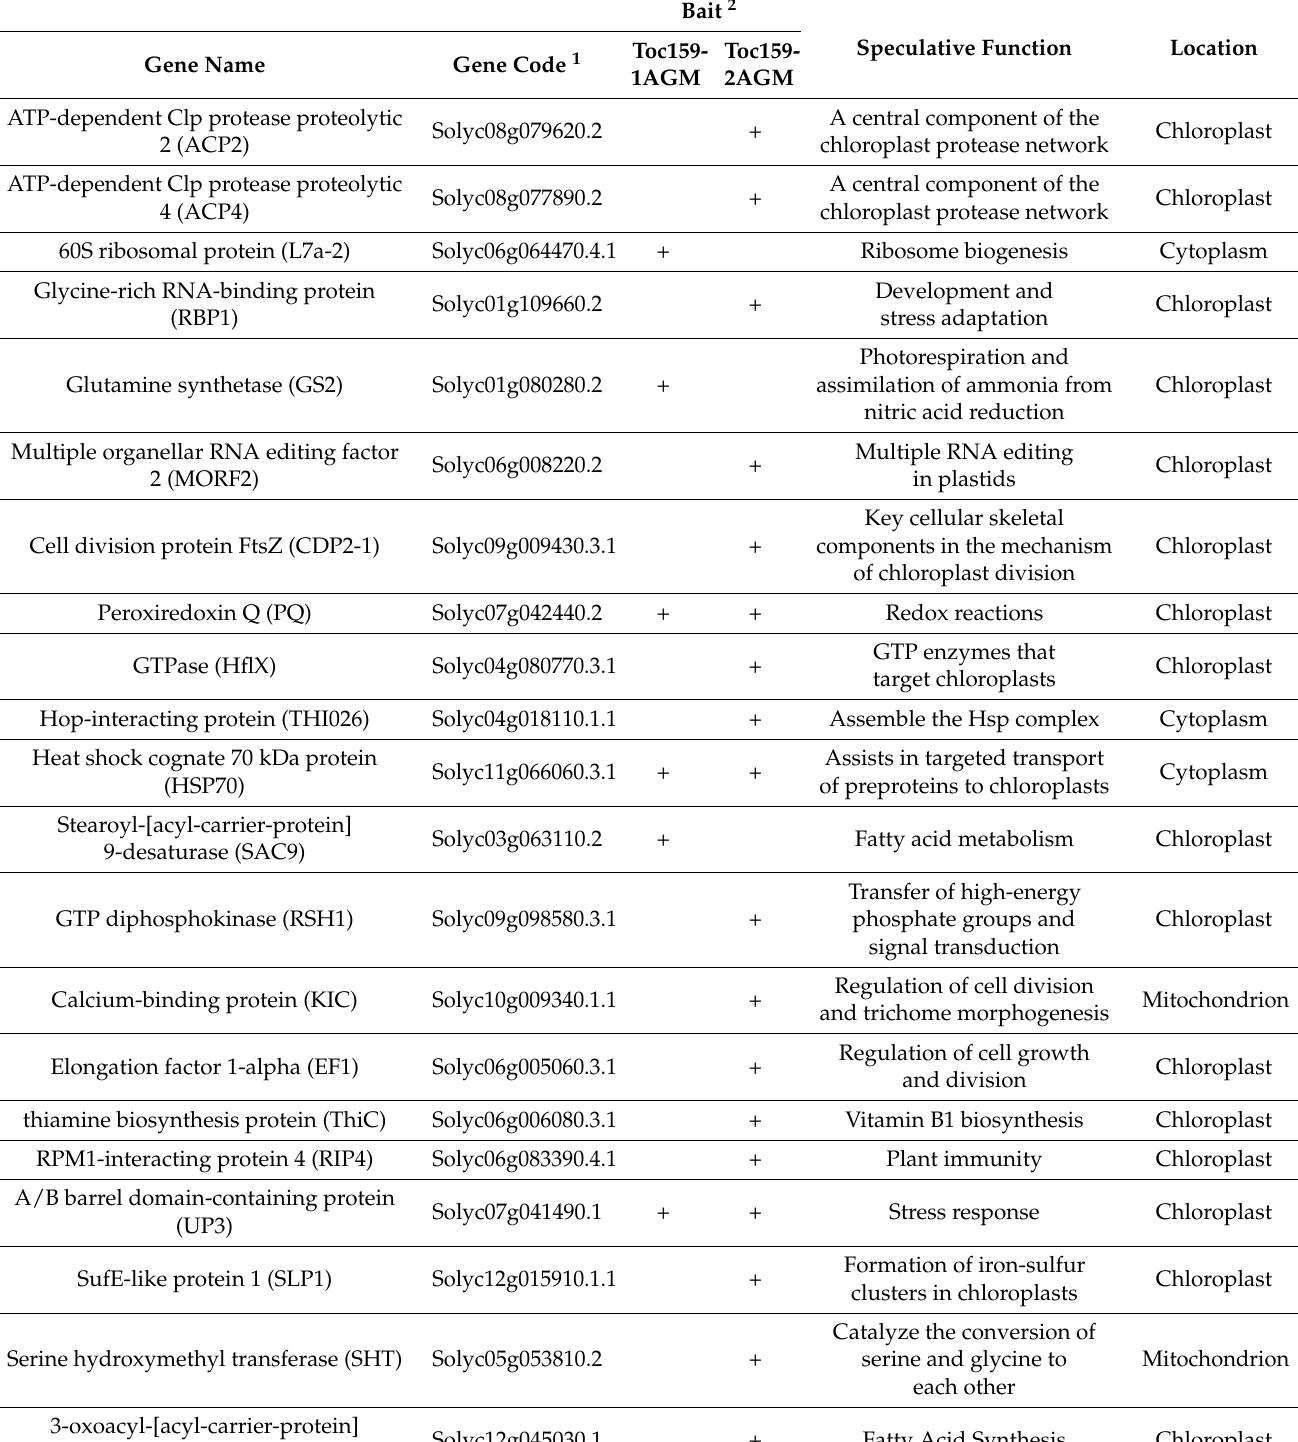
Table 3. Non-photosynthesis-related proteins identified to interact with slToc159-1 and slToc159-2 in a split-ubiquitin yeast two-hybrid